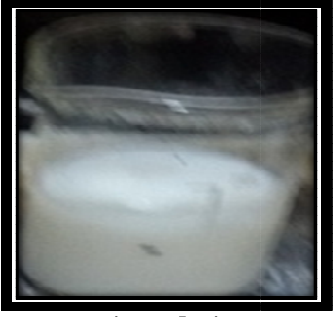
Figure 1: Coating solution preparation Discs and screws and screws coating